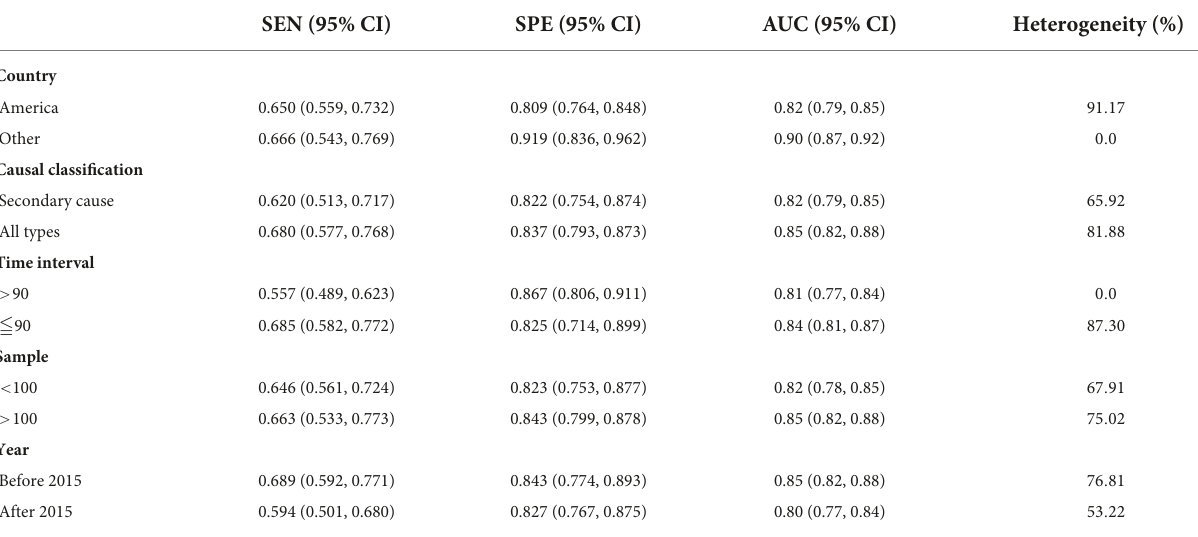
TABLE 2 Diagnostic accuracy summary of subgroup